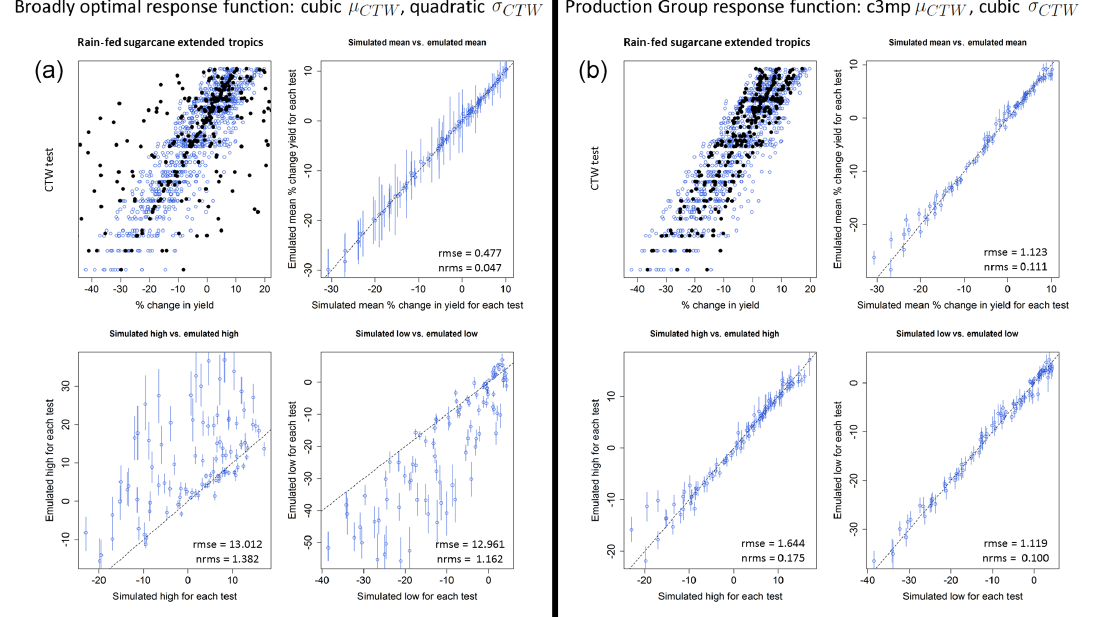
Figure 5. Rain-fed sugarcane in the extended tropics. (a) The performance dashboard for the most broadly optimal functional form repre- sentations (i.e., if we want to use the same functional form combination for all production groups), and for which the high and low response functions poorly reproduce the simulated high and low yields for each of the 99 tests. (b) The performance dashboard for the production- group-specific functional forms (i.e., if we want the functional form to vary by production group). Vertical error bars indicate the 95% credible interval for each of mean, high, and low emulated responses.